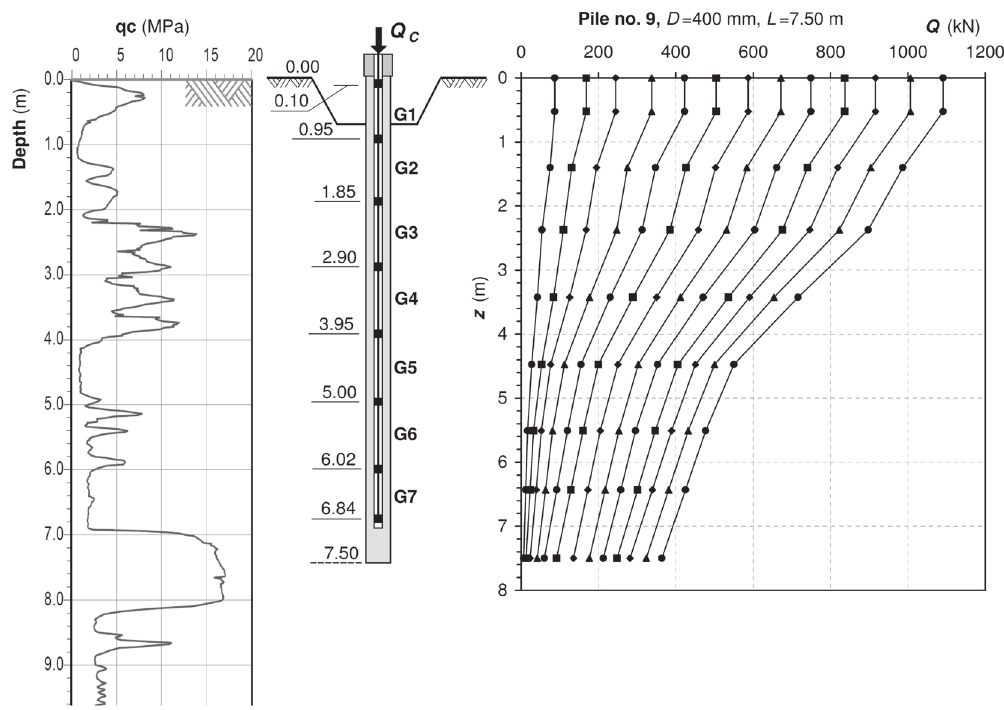
Figure 14: Pile no. 9. Axial load distribution along the pile shaft without taking into account the influence of the residual force.